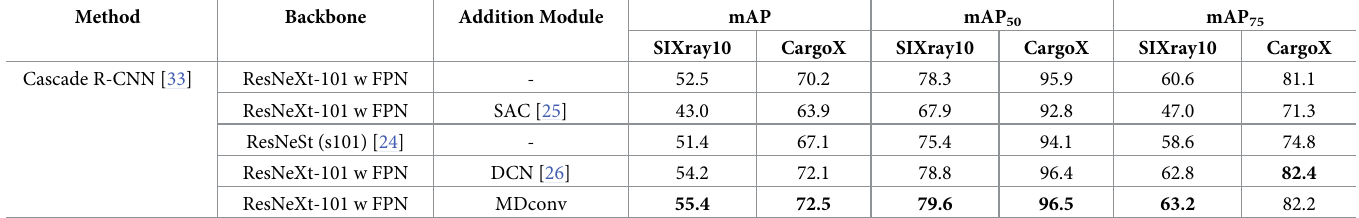
Table 2. Comparison of the performance of the MDConv module with previous applications of conditional convolutional modules on the backbones of object detec- tors on the SIXray10 and CargoX datasets.